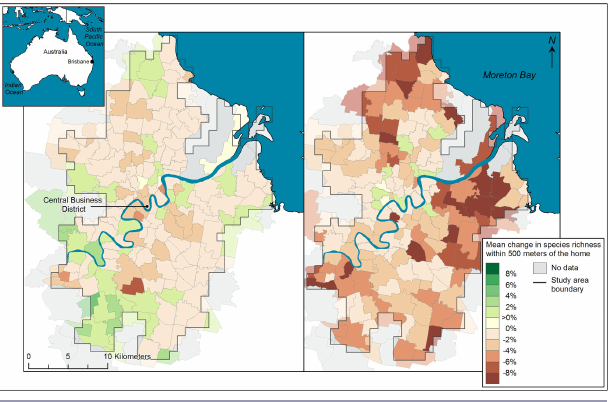
Fig. 4 . Mean proportional change in bird species richness within a 500 meter radius of the home for each suburb in the study area for (a) compact and (b) sprawling urban growth scenarios. Suburbs with a mean increase or no change in species richness within 500 meters of the home are colored dark to light green while suburbs with a mean decrease in species richness within 500 meters of the home are colored light to dark